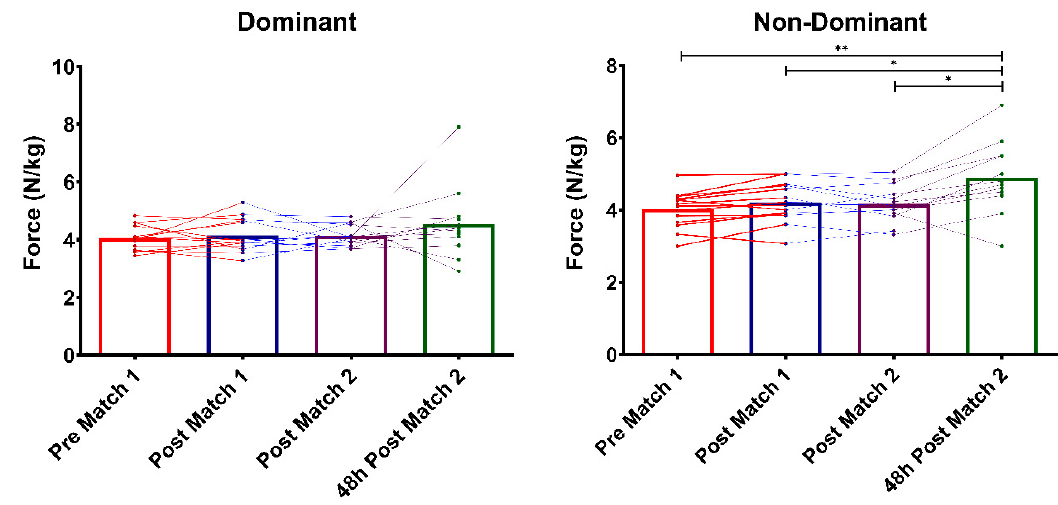
Figure 2. Mean and individual isometric knee flexion strength in the dominant and non-dominant limbs at the different tests. * represents a significant difference at p < 0.05, and ** represents a significant difference at p < 0.001.